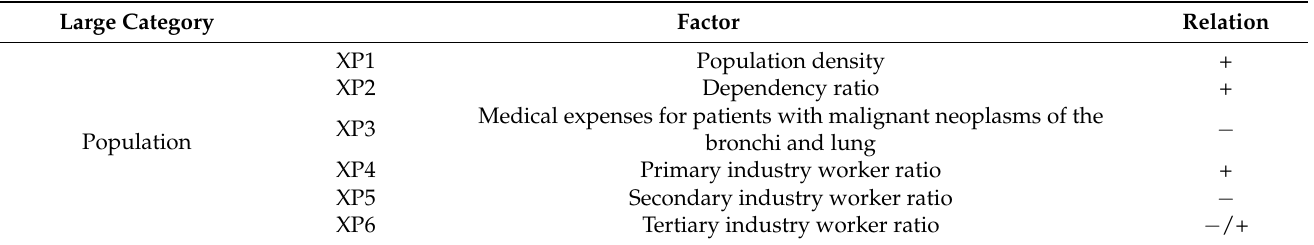
Table 4. The results of risk detection for the influencing factors of urban PM 10 and PM 2.5 in 2019 .